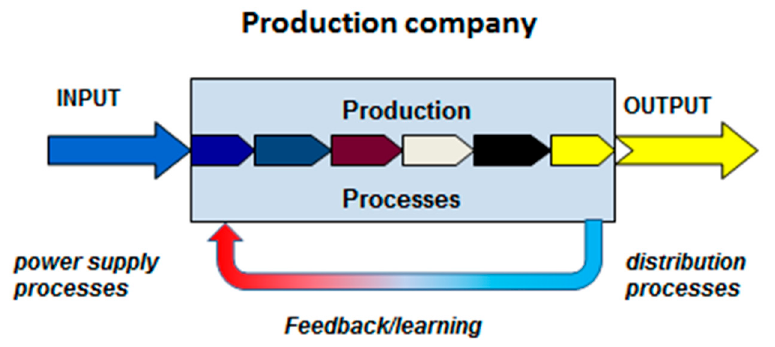
Figure 1. Idea of production processes in a learning organization using machine learning.